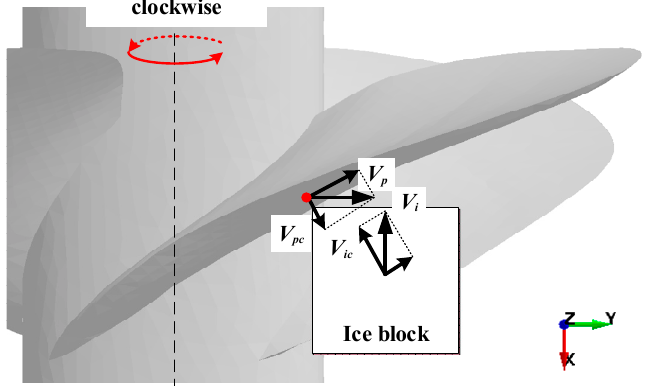
Figure18. Schematicdiagramofthespeedduringpropeller–iceimpactingprocessforclockwiserotation. J. Mar. Sci. Eng. 2019 , 7 , x FOR PEER REVIEW Figure 18. Schematic diagram of the speed during propeller–ice impacting process for clockwise rotation.